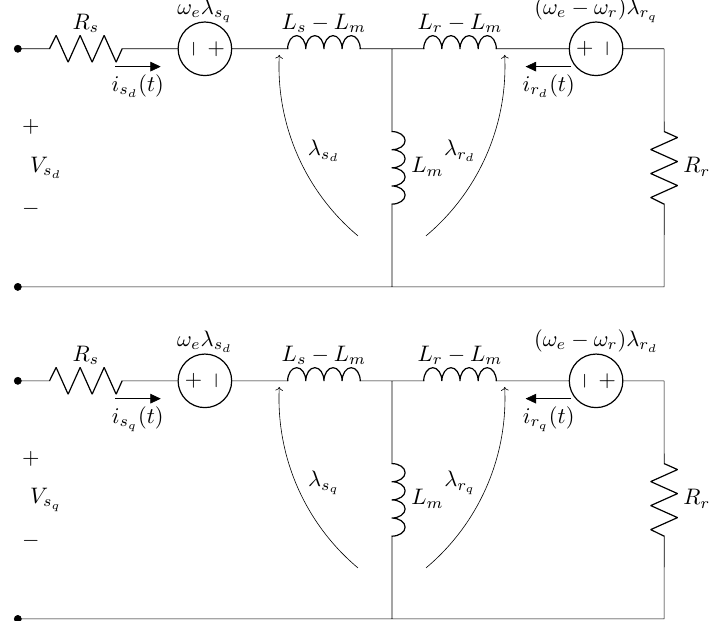
Figure 2. In the reference frame of a synchronously rotating asynchronous machine, we can represent the two phases d-q via an equivalent